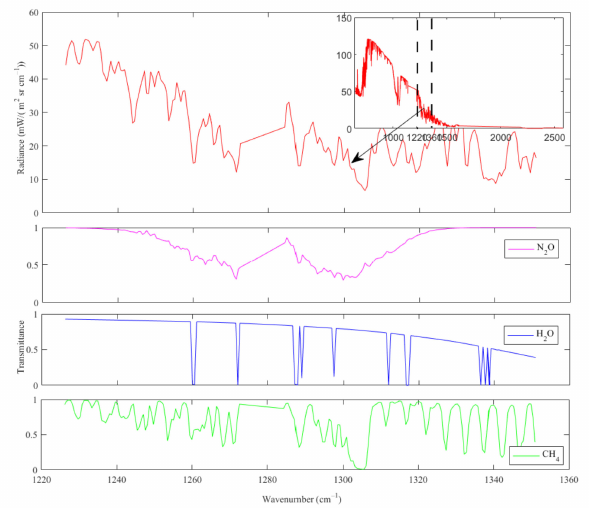
Figure 2. A segment of the AIRS spectrum near the υ 1 absorption band of N 2 O (top plot) and the transmittances of N 2 O, water vapor and CH 4 (bottom three plots) in the MWIR range. Figure 3 presented the changes in BTs caused by the changes in N 2 O, water vapor, and CH 4 concentrations, the absorption band of N 2 O is overlapped with the absorption of CH 4 and water vapor. Considering the AIRS channel noise [20], only two channels (at 1291.1395 and 1291.7086 cm − 1 ) that are most sensitive to N 2 O but have less interference from other gases are selected, as marked in Figure 3. Using a similar method, some channels sensitive to N 2 O in υ 3 band are selected, as shown in Figures 4 and 5. This is the first step of channel selection.